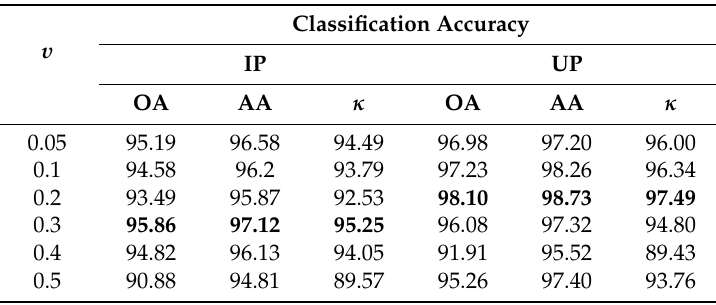
Table 8. Classification accuracy (%) by the SVM-SSHK method under different values of υ for the IP and UP images. The best accuracies are indicated in bold in each